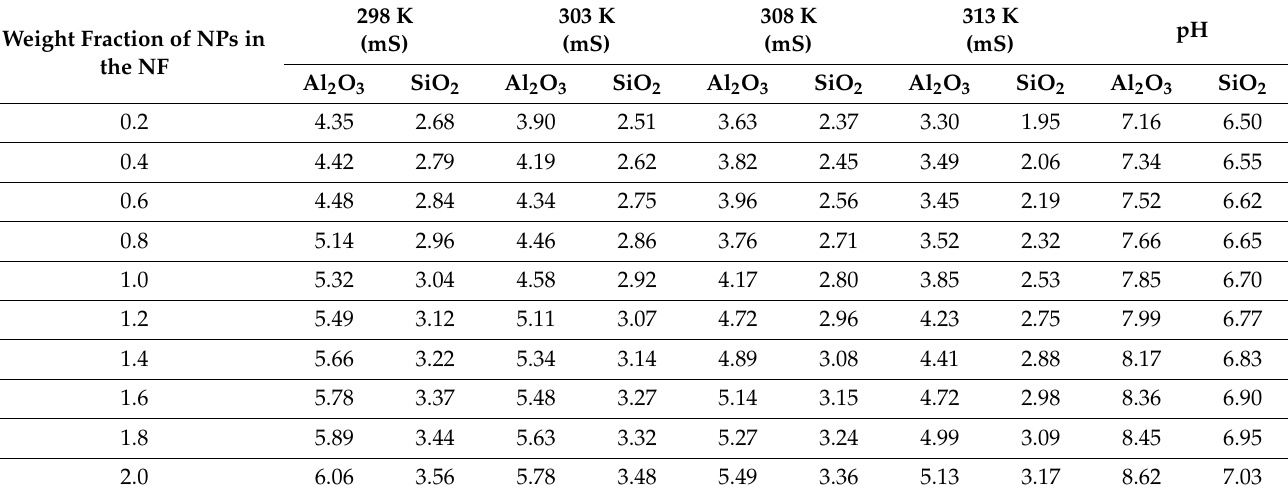
Table 3. Variation in electrical conductivity and pH of Al 2 O 3 and SiO 2 with weight fractions. Weight Fraction of NPs in the